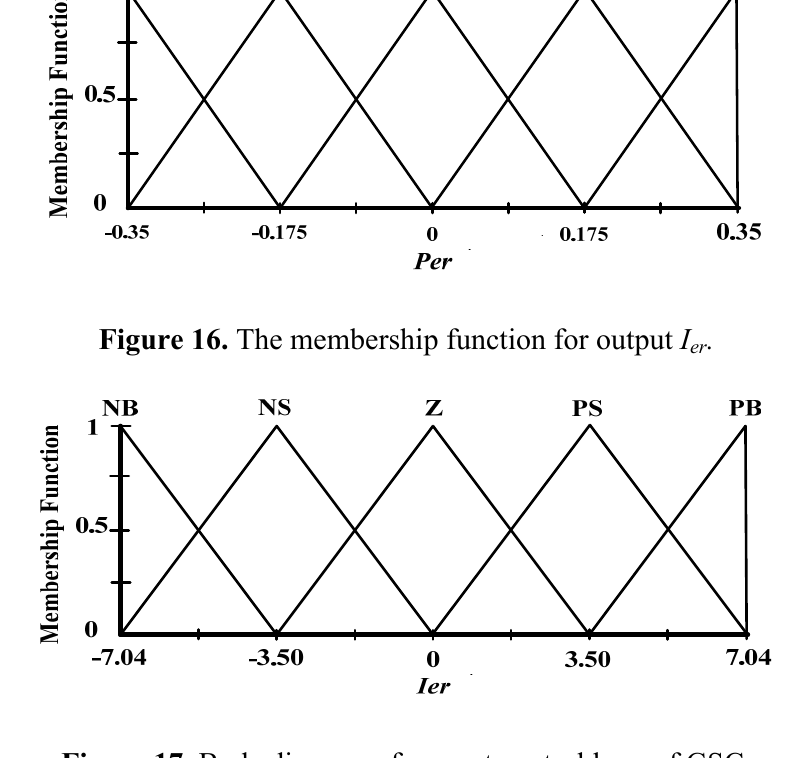
Figure 15. The membership function for output P